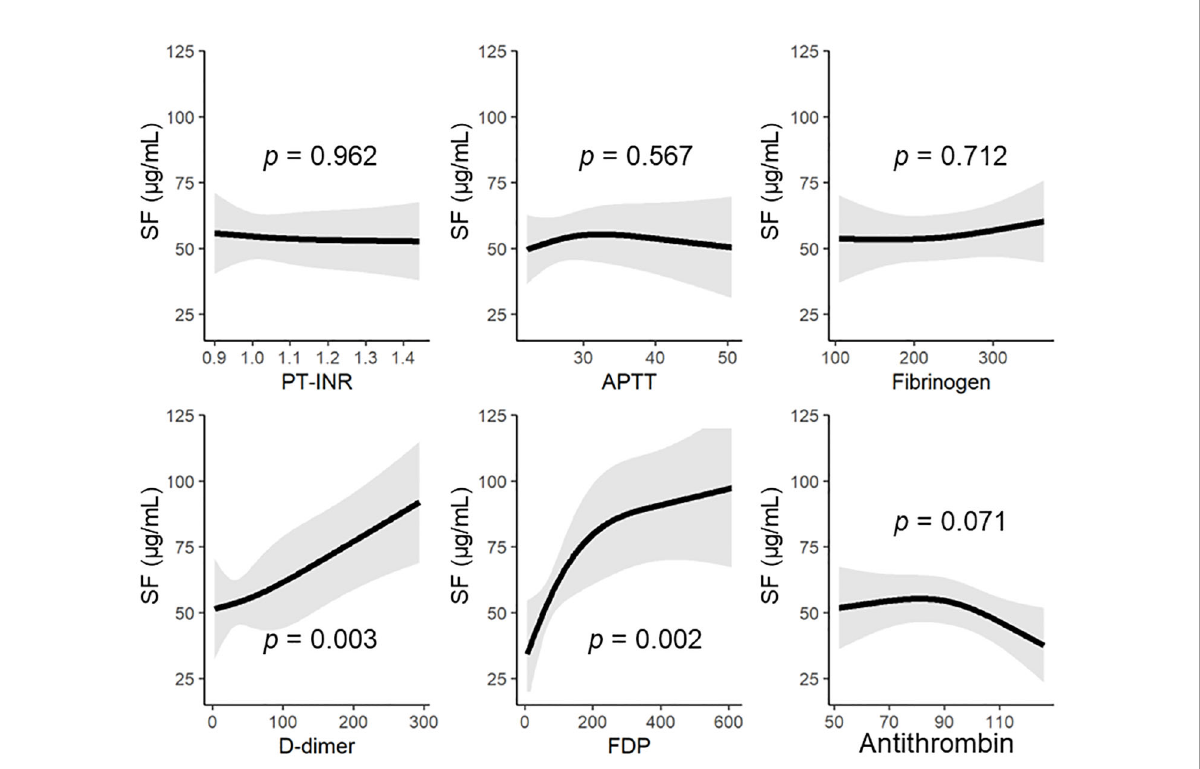
FIGURE 1 The SF levels on hospital arrival based on the general coagulo fi brinolytic markers, including antithrombin. Regression lines of the levels of SF were estimated by multivariable nonlinear regression analyses, with adjustment for the patients ’ age and sex. The nonlinear association was allowed by a restricted-cubic-spline function with three knots. APTT, activated partial thromboplastin time; AT, antithrombin; FDP, fi brin/ fi brinogen degradation products; PT-INR, prothrombin time International Normalized Ratio; SF, soluble fi